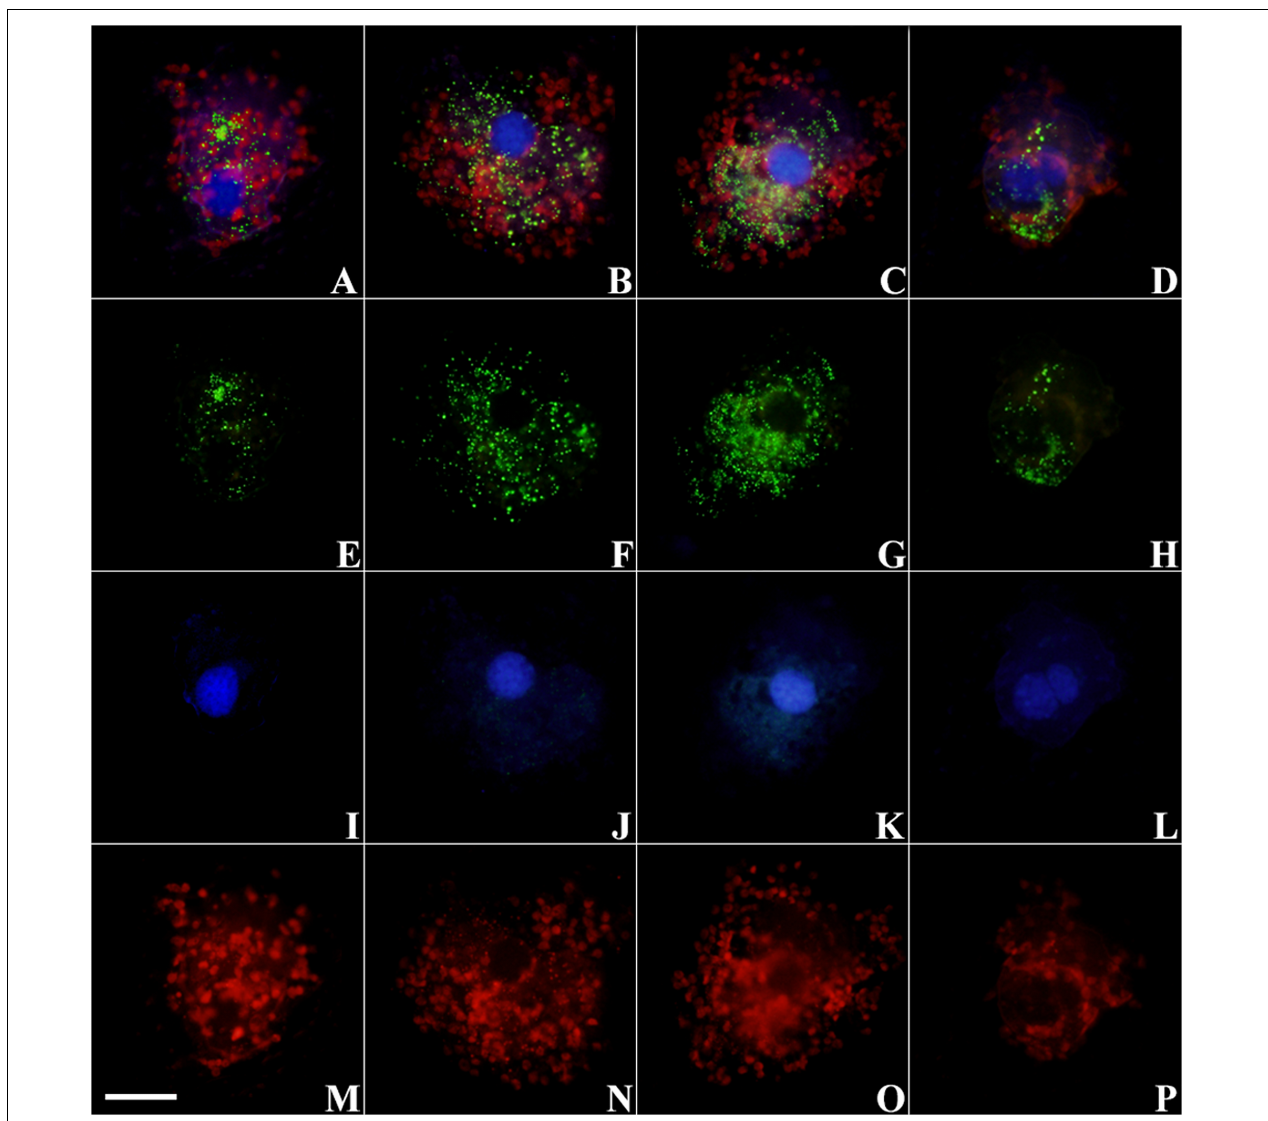
FIGURE 2 | Micrographs of S . cf. basimorphum cells hybridized with the probe for the prey rRNA (Alexa Fluor 488 dye labeled) and counterstained with DAPI at different time intervals. Combined light channels: (A) T0, actively feeding cells; (B) T2, prey depleted; (C) T5, prey starved; (D) T7, prey starved. Single light channels are shown below each cell: (E–H) light channel for the FISH probe, showing prey rRNA; (I–L) light channel for DAPI, showing ciliates nuclei; and (M–P) light channel for chlorophyll autofluorescence, showing chloroplasts. The scale bar in the left bottom corner is 20 µ m and refers to all panels. Blue, ciliates nuclei; green, prey RNA; red,